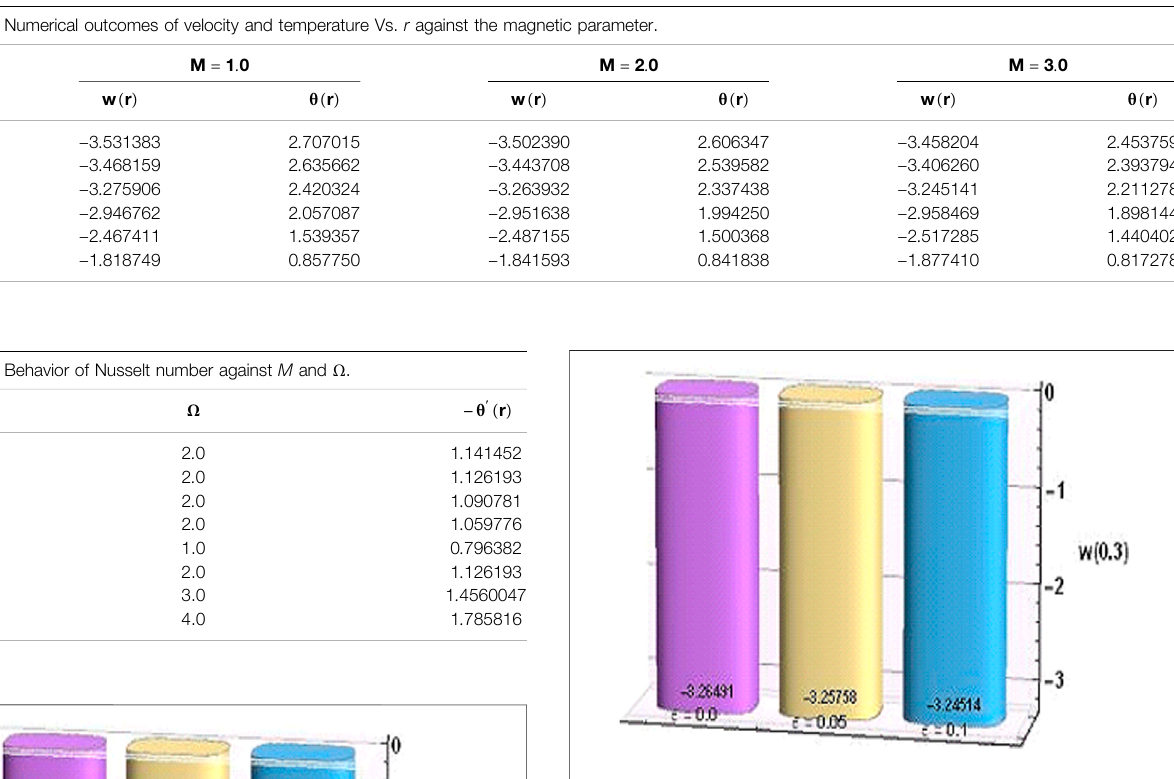
FIGURE 20 | Velocity for cilia length parameter at r (cid:1)